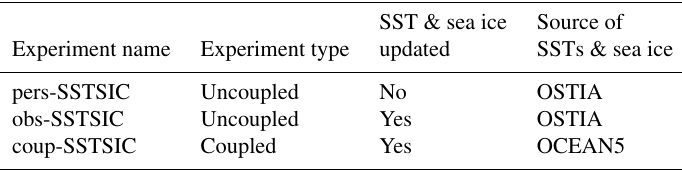
Table 1. Configuration of